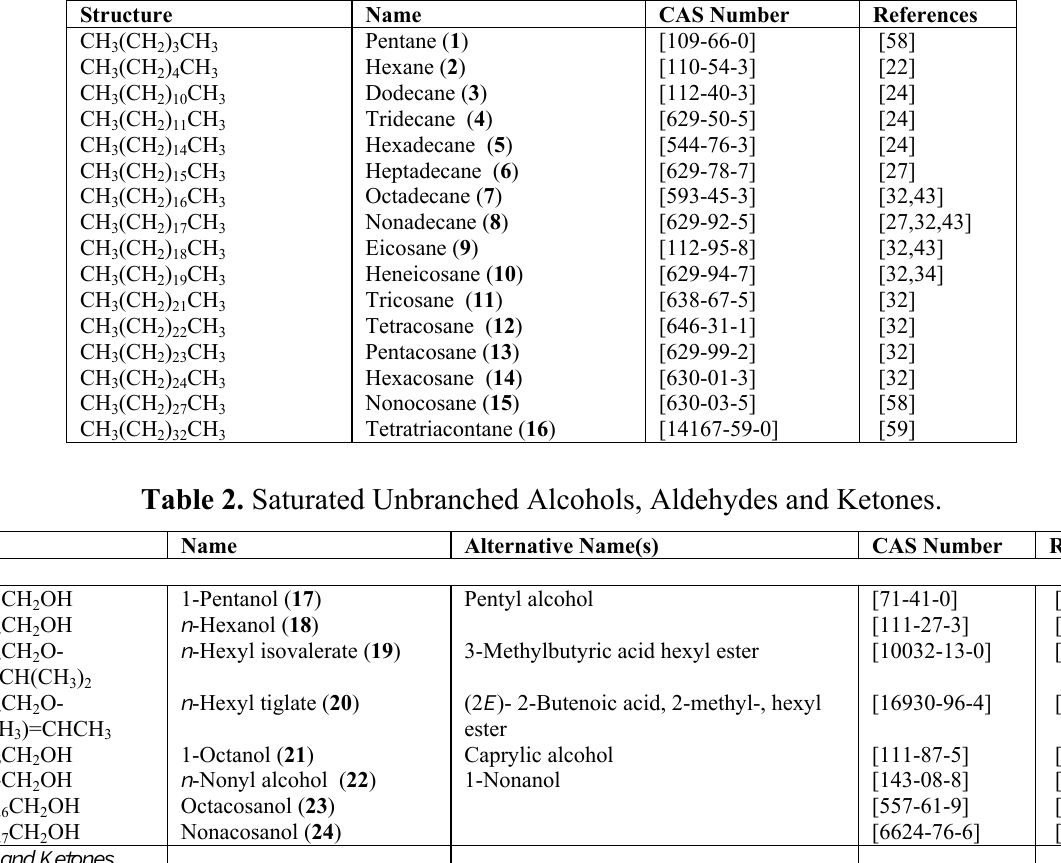
Table 1. Saturated Unbranched Hydrocarbons.